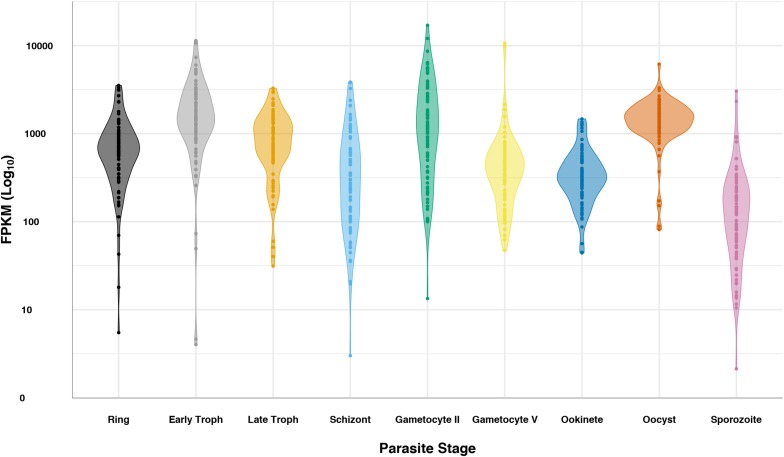
Plasmodium falciparum ribosomal protein expression over life cycle. RNAseq data (López-Barragán et al., 2011; Zanghì et al., 2018) for the 82 cytosolic ribosomal proteins was queried from PlasmoDB (Aurrecoechea et al., 2009) for ring, early trophozoite, late trophozoite, schizont, gametocyte II, gametocyte V, ookinete, oocyst, and sporozoite stages. Data is displayed in log scale as a violin plot, showing the general trend of ribosomal protein transcripts. Data for each ribosomal protein is represented as a dot in the plot.